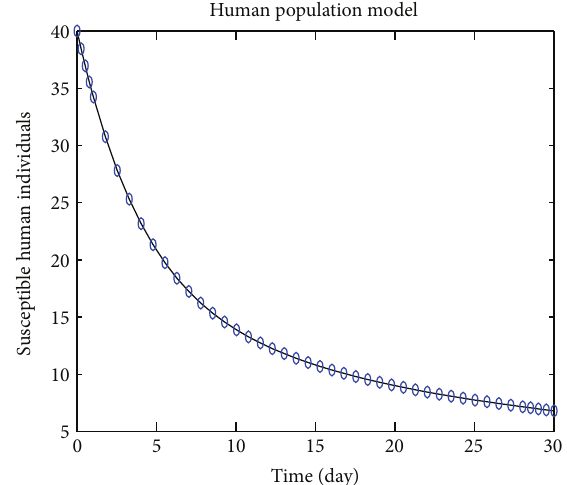
Figure 1: The dotted line and the solid line connectively show the Runge-Kutta method and MSGDTM.